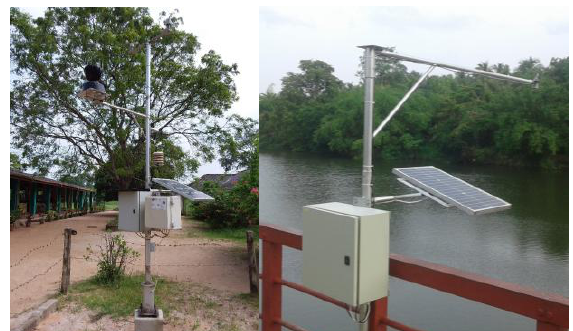
Figure 4. On the left 4onse-mod station deployed in Kubukgete Central College (SL); On the right river gauge installed in Ridie